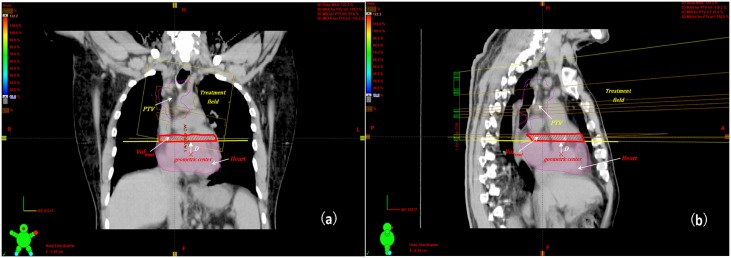
Definition of beam-to-heart distance and irradiated heart volume in lung cancer radiotherapy with a coronal view (a) and a sagittal view (b).The beam-to-heart distance (D) will be a positive value when the geometric center of the heart is located outside of the irradiated heart volume, and a negative one when it falls within the irradiated heart volume.